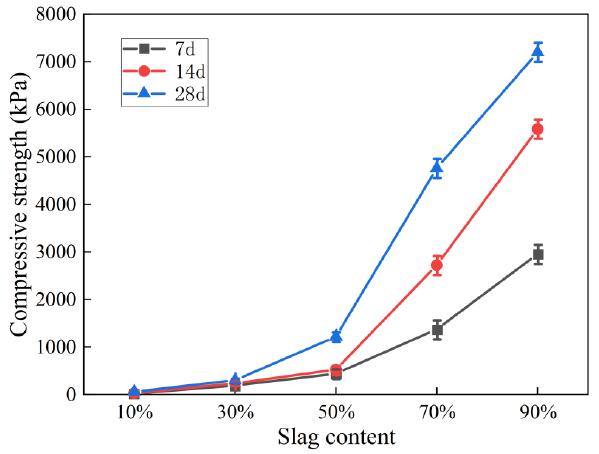
Figure 1. UCS of stabilized soils with different slag